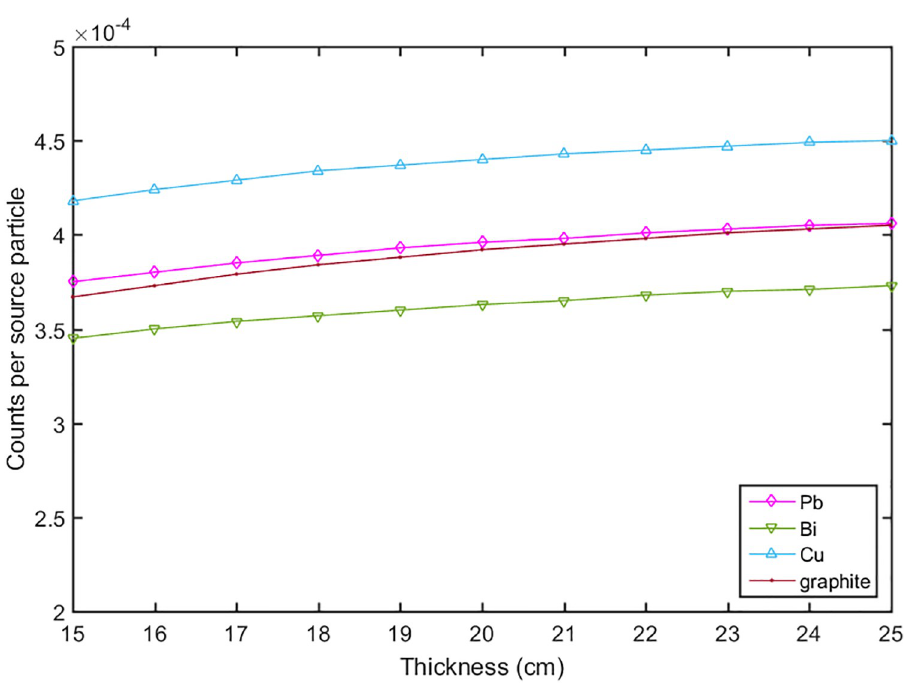
Fig 4. The neutron flux versus the thicknesses of t3 with different